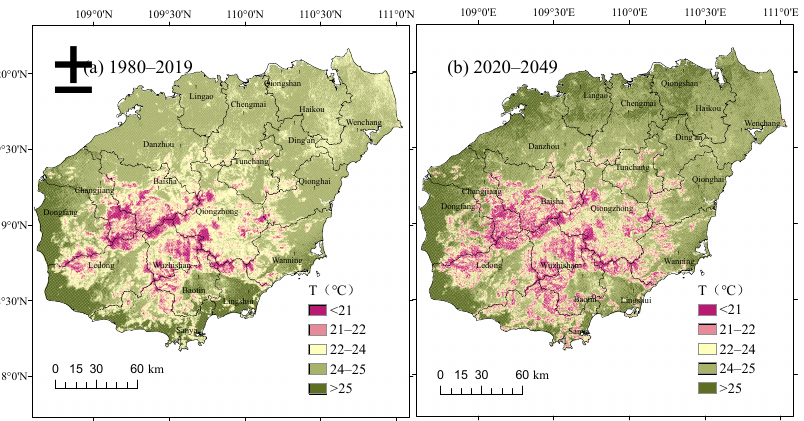
Figure 3. ( a ) Spatial distribution of average temperature from 1980 to 2019, ( b ) Spatial distribution of average temperature in 2020–2049 under RCP4.5 scenarios (annual average temperature represented by T in the figure.).